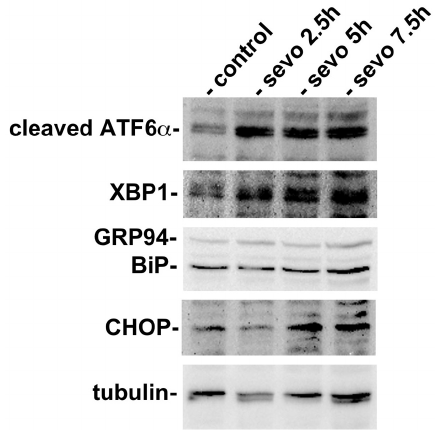
Figure 1. Exposure to sevoflurane resulted in the initiation of the unfolded protein response (UPR). Neuro2a cells were cultured and exposed to 3% sevoflurane for 2.5, 5, or 7.5 h. The cells were then collected and analyzed by western blotting. Sevoflurane exposure activated ATF6 and induced the expression of XBP-1, a transcription factor that enhanced the expression of BiP, a major endoplasmic reticulum (ER) chaperone. GRP94, another ER chaperone is recognized by the anti-KDEL antibody. CHOP, a transcription factor responsible for initiating apoptotic cell death during ER stress, was expressed at significantly higher levels after 7.5 h of exposure.